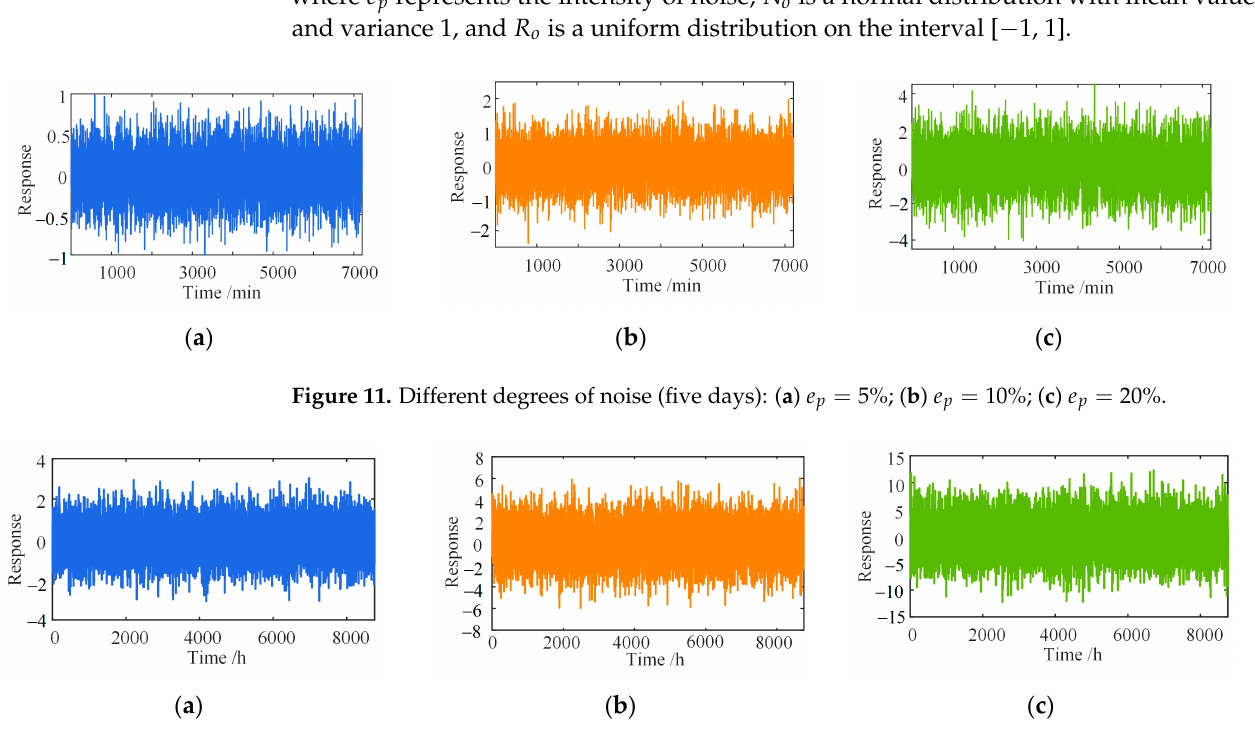
Figure 10. Separation error in different time windows. ( a ) Five days; ( b ) one year.